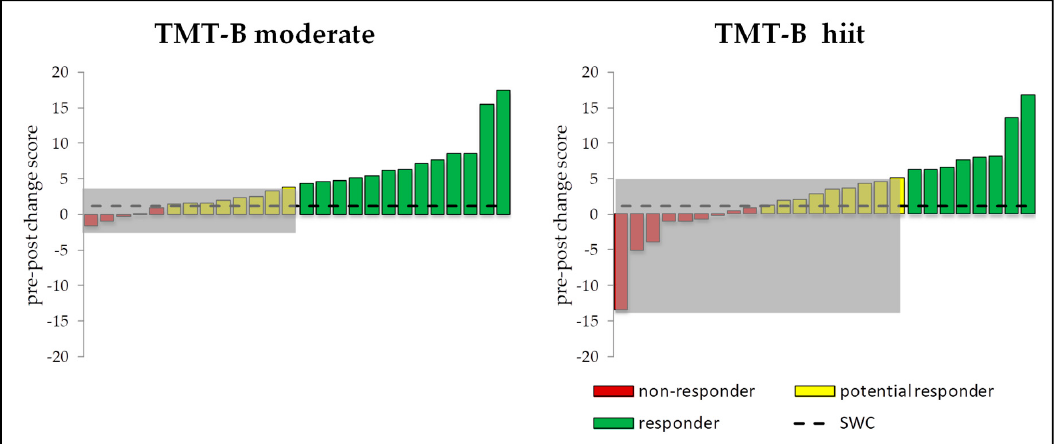
Figure 8. Individual response calculated with SWC (0.2 × between-standard deviation) and 50% CI (pre-post change ± typical error) for all subjects of the experimental groups ( n = 26) for TMT-B moderate (left) and hiit (right) condition. Green bars labels responder (true score change CI above SWC), the grey area marks non-responder. The other subjects are divided into potential responder with true score change above SWC but below CI (yellow bars) and non-responder with true change score CI below SWC (red bars). Positive value reflects an increase of cognitive performance, a negative value vice versa.